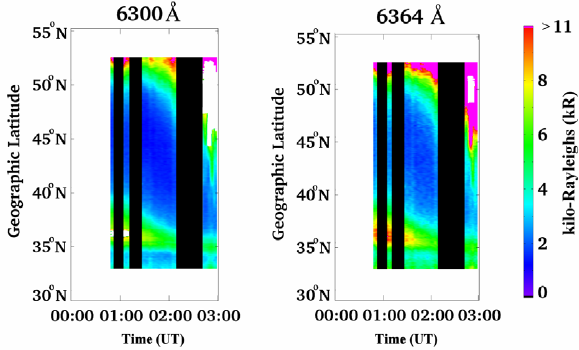
Figure 5. Meridional imaging spectrograph data taken at Millstone Hill on the night of 29 October 1991. Shown are the brightness levels versus latitude (assuming a 400 km emission height for 6300 Å and 6364 Å) over a 150 o FOV as a function of time. Brightness levels are given in Rayleighs (R). No significant levels of emission were observed in the vicinity of the SAR arc at any other wavelength observed over the range 5400 to 7400 Å. Data gaps were due to either detector saturation (white) or periods when the observers were adjusting exposure times (black). The 6364 Å brightness was scaled to the 6300 Å brightness (see text).